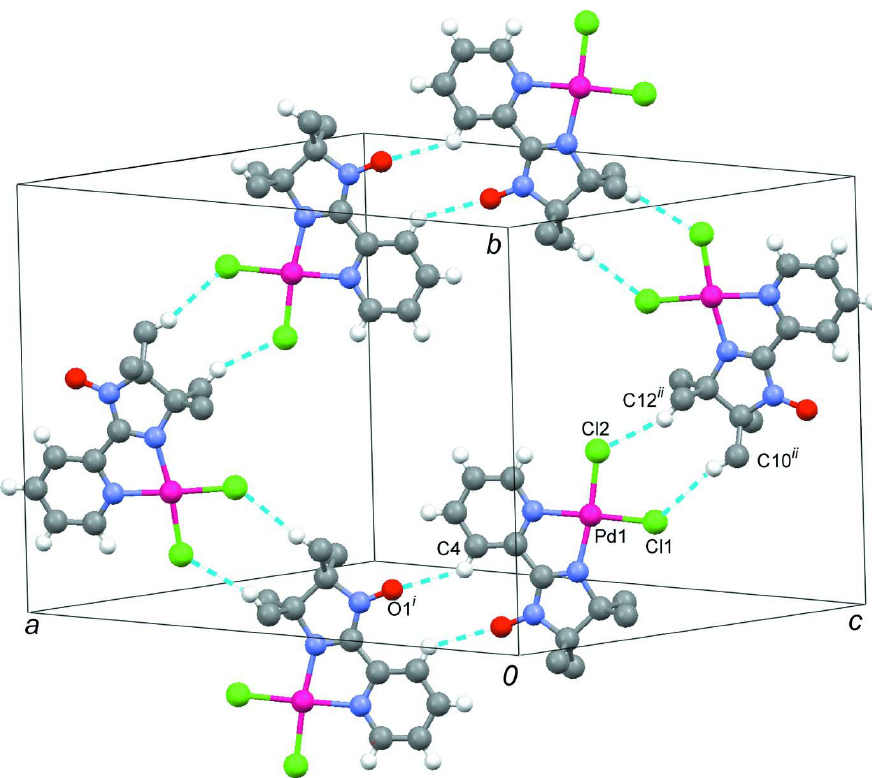
Figure 2 Partial packing view showing the formation of a two-dimensionnal network through C—H···O and C—H···Cl intermolecular interactions. H bonds are shown as dashed lines. H atoms not involved in hydrogen bonding have been omitted for clarity. [Symmetry codes: (i) - x –+1, - y , - z + 1; (ii) 1/2 - x , y + 1/2, 3/2 - z ]